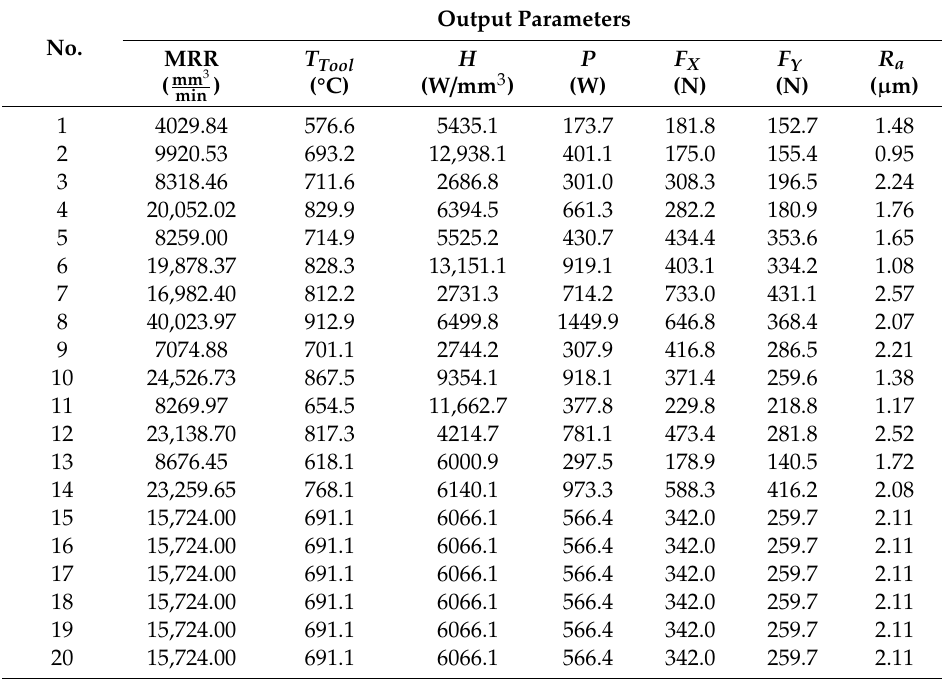
Table 5. Empirical Data based on the quadratic objective